Question: In one sentence, what is this figure communicating?
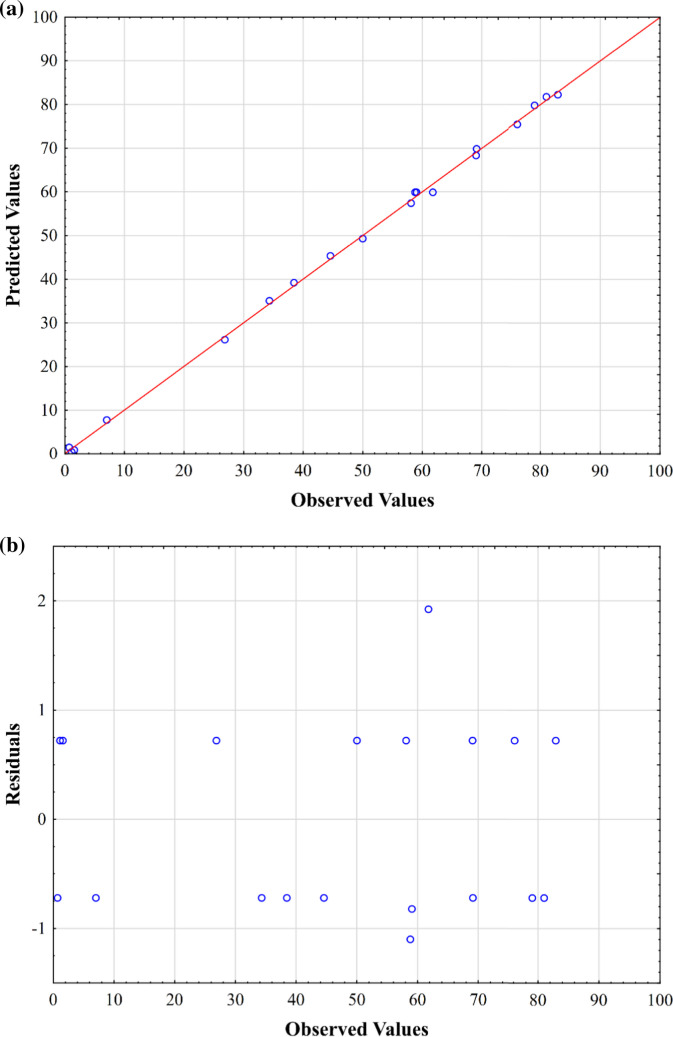
Answer: Plots of the linear model from the screening experiments for optimizing ferrous sulfate production: ( a ) observed versus predicted values and ( b ) residual versus observed values